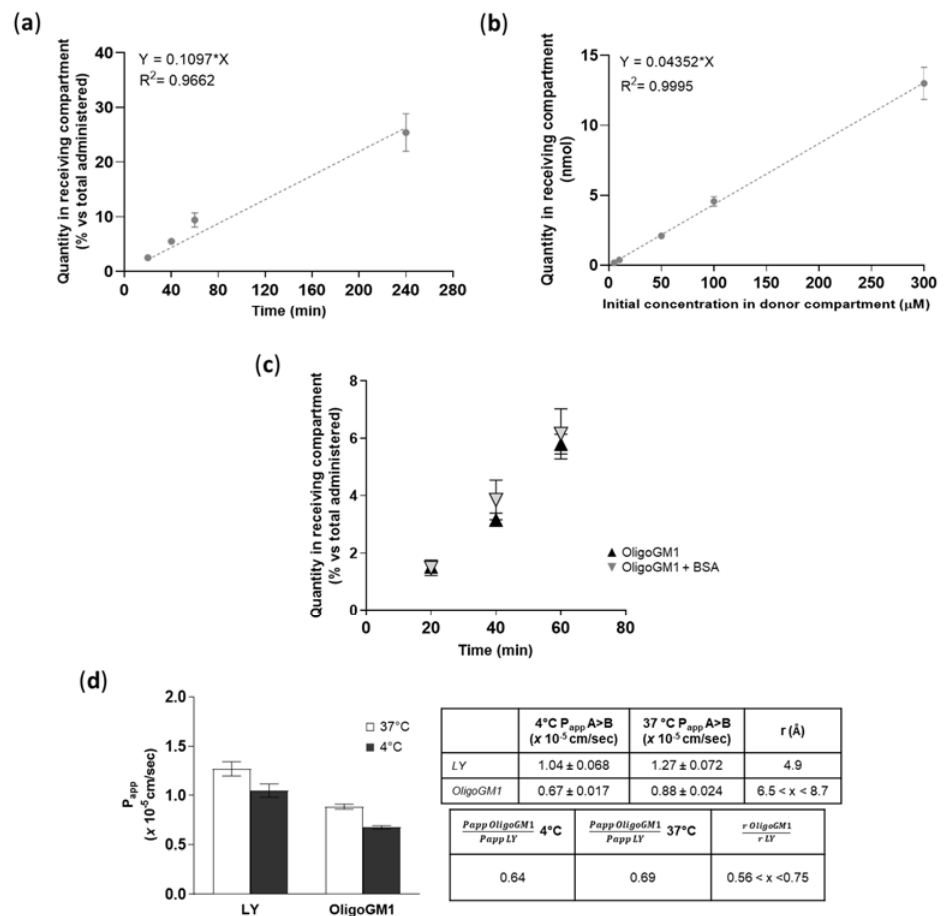
Figure 6. OligoGM1 transport characterization across hBLECs. ( a ) E ff ect of time on OligoGM1 direct transport experiment (A → B). Here, 50 µ M plus 1 × 10 6 dpm OligoGM1 was added to the apical compartment and the related quantity of OligoGM1 found in the receiving compartment after 20, 40, 60, and 240 min was measured. Data are expressed as nmol in the receiving compartment versus nmol administered (%, mean ± SEM), derived from 4 di ff erent experiment examining a minimum of 3 wells for each condition ( n = 4). The regression model was fitted with a linear equation [y = 0.1097 × x ], while Pearson’s correlation coe ffi cient (r 2 ) = 0.9662. ( b ) E ff ect of dose on OligoGM1 direct transport experiment (A → B). Here, 5, 10, 50, 100, or 300 µ M plus 1 × 10 6 dpm OligoGM1 was added to the apical compartment and the related quantity of OligoGM1 found in the receiving compartment after 60 min was measured. Data are expressed as nmol in the receiving compartment (mean ± SEM), derived from 4 di ff erent experiments examining a minimum of 3 wells for each condition ( n = 4). The regression model was fitted with a linear equation [y = 0.04352 × x ], while Pearson’s correlation coe ffi cient (r 2 ) = 0.9995. ( c ) Influence of BSA on OligoGM1 direct transport experiment (A → B). Here, 50 µ M plus 1 × 10 6 dpm OligoGM1 was added to the apical compartment in the absence ( (cid:78) ) or presence ( (cid:72) ) of 0.1% BSA ( w / v ), and the related quantity of OligoGM1 found in the receiving compartment after 20, 40 and 60 min was measured. Data are expressed as nmol in the receiving compartment versus nmol administered (%, mean ± SEM), derived from 4 di ff erent experiments examining a minimum of 3 wells for each condition ( n = 4). ( d ) E ff ect of temperature on OligoGM1 direct transport experiment (A → B). Here, 50 µ M LY or 50 µ M plus 1 × 10 6 dpm OligoGM1 was added to the apical compartment. After 60 min, the Papp values ( × 10 − 5 cm / s) were calculated. Left: Papp of LY and OligoGM1 measured after 60 min of hBLECs incubation at 37 ◦ C ( (cid:3) ) or 4 ◦ C ( (cid:4) ). Results are mean ± SEM from 4 independent experiments ( n = 4) performed by examining a minimum of 3 wells for each condition. Right: Table indicating the ratio between Papp values at 4 ◦ C or 37 ◦ C and the ratio of the hydrodynamic radius (r) for LY and